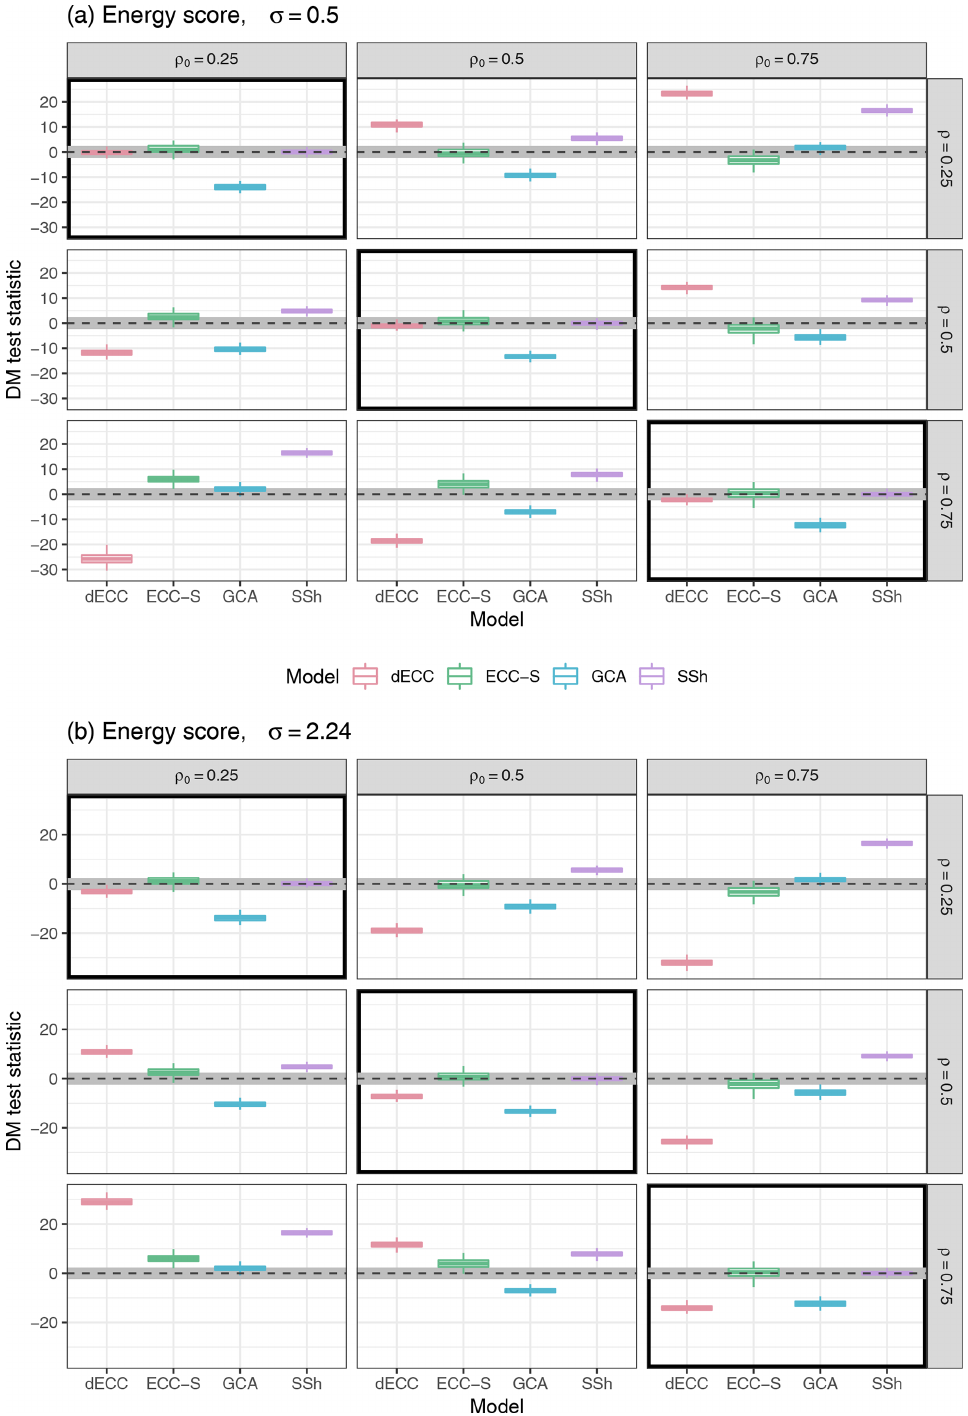
√ 5 (b) . ECC-Q forecasts